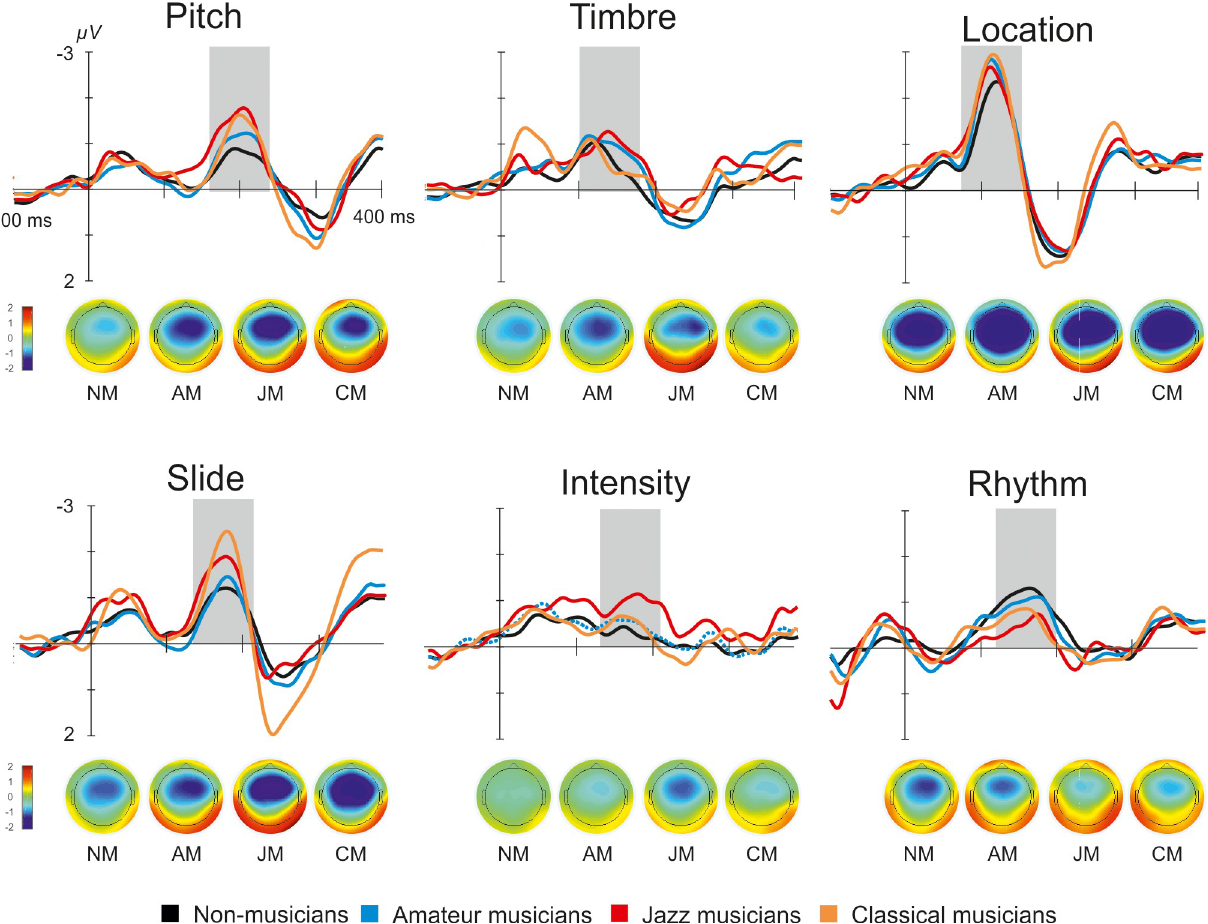
Fig 2. Grand averaged difference waveforms and topographic maps of MMN for four groups and six deviants recorded at Fz electrode. Grey area marks MMN peak.